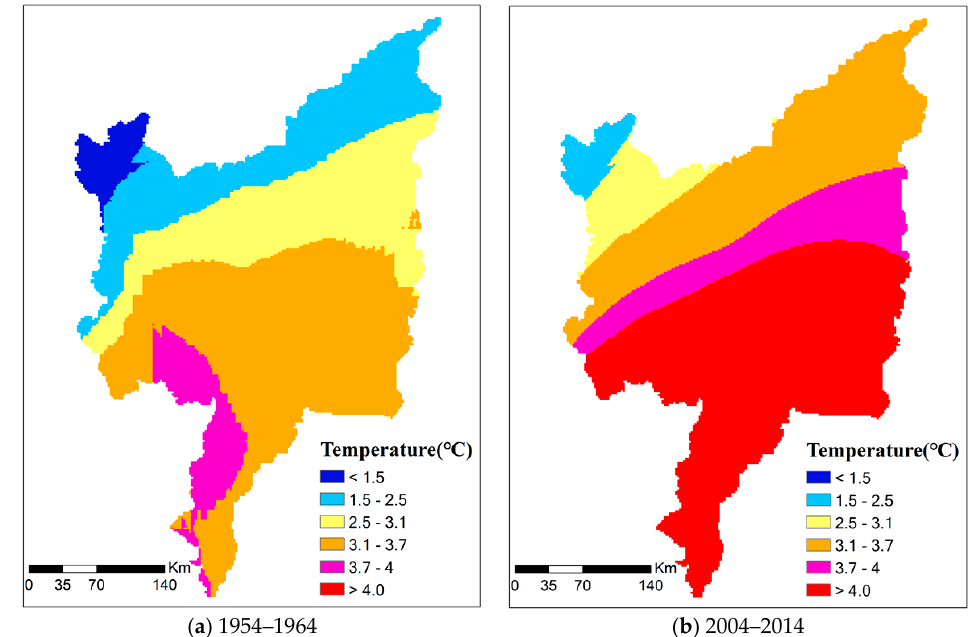
Figure 11. ( a ) Average temperature from 1954 to 1964 and ( b ) average temperature from 2004 to 2014.